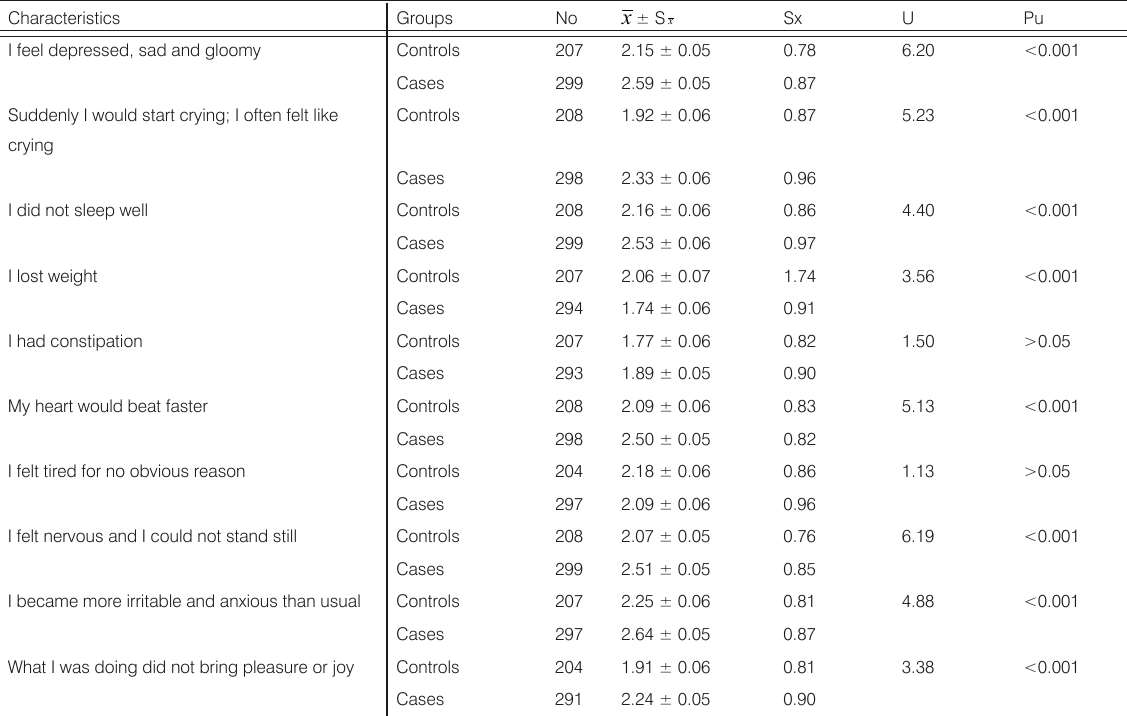
groups.Risk Table 3. Mean levels of depression in relation to the characteristics of the